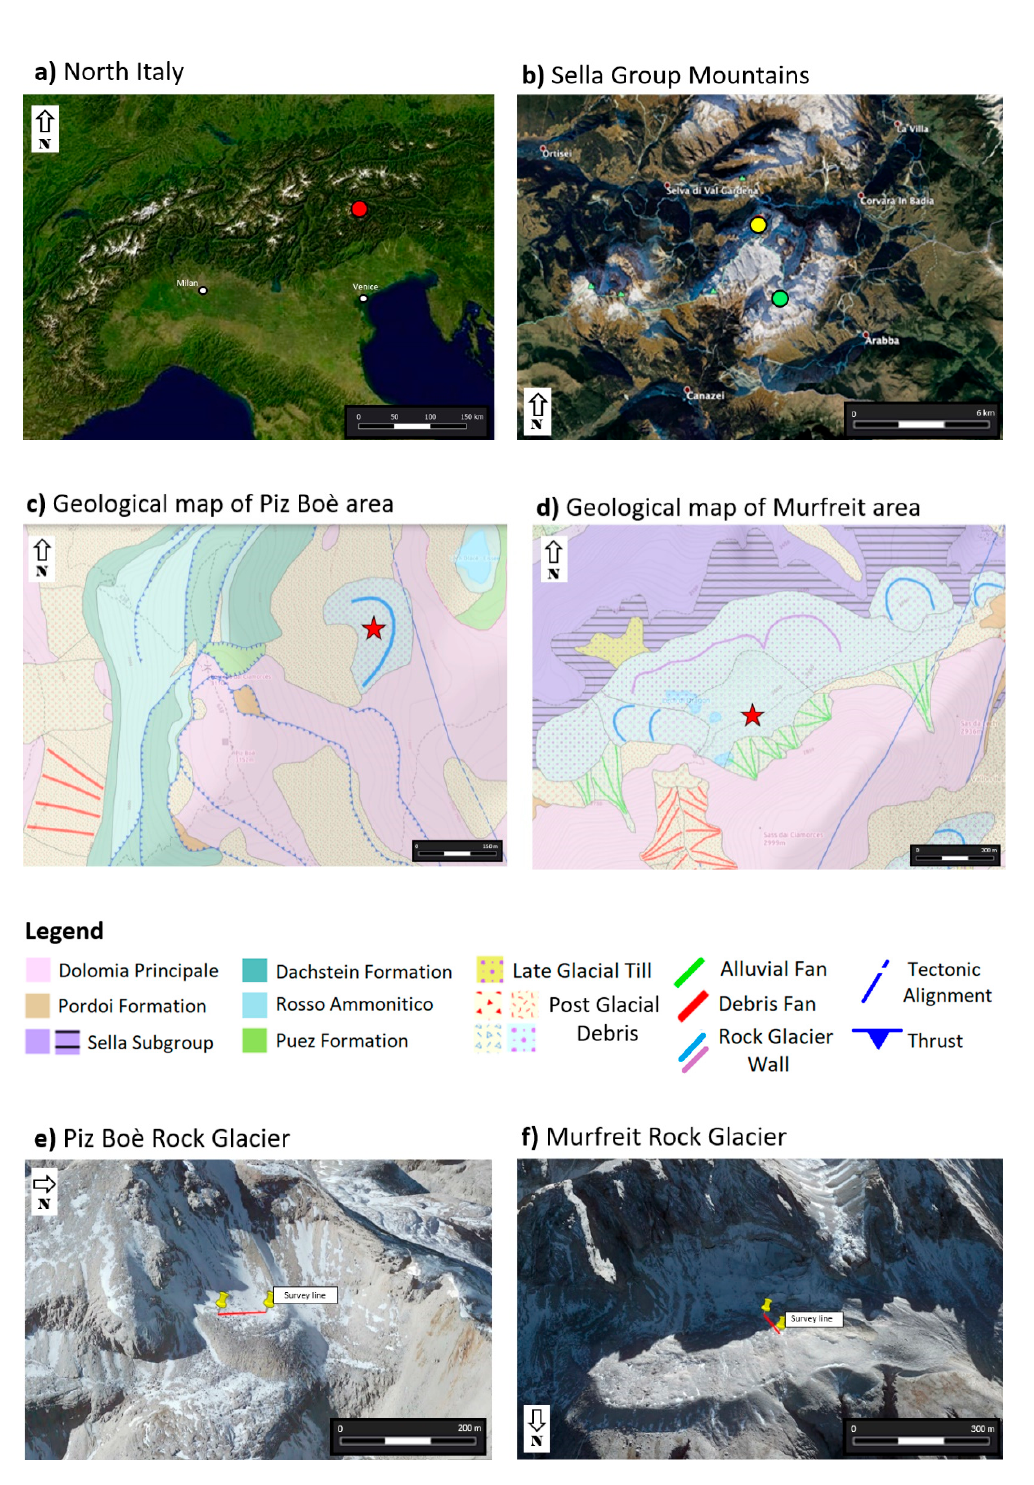
Figure 1. ( a ) The position of Sella Group mountains in Northeastern Italy (red dot); ( b ) the location of the Murfreit (yellow dot) and Piz Bo è (green dot) rock glaciers in the Sella Group mountains; ( c ) geological map of the Piz Bo è area (red star is the survey position); ( d ) geological map of the Murfreit area (red star is survey position); ( e ) the survey line performed on the Piz Bo è rock glacier (red line); ( f ) the survey line executed on the Murfreit rock glacier (red line). On the contrary, the investigation line performed on the rock glacier of Piz Boè was defined orthogonally to its development (Figure 1e). Piz Boè is located on the Southeast side of Sella Group mountains (see Figure 1b) and the rock glacier, or rather the debris-